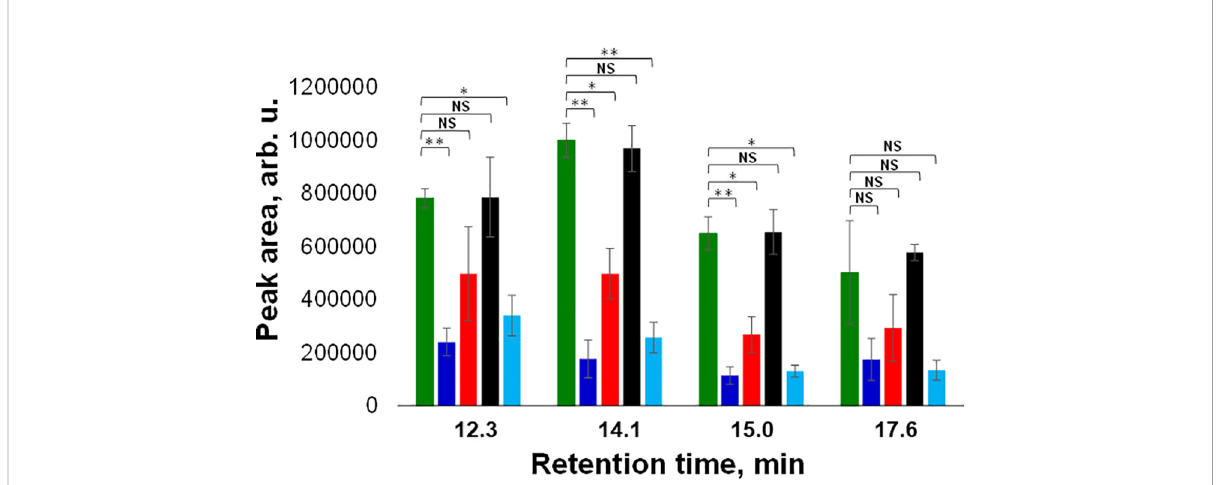
FIGURE 4 Average peak area and corresponding standard deviations of peaks observed in triplicates of HPLC pro fi les of healthy (green), ND- (light blue) and drought (black) stressed plants, as well as wheat exposed to WSMV+TriMV infection (red) and aphid stress (blue). RT=12.3 min = lutein; RT=14.1 min = chlorophyll; RT=15.0 min = pheophytin; RT=17.6 min = b-carotene. NS is a nonsigni fi cant difference, and *P ≤ 0.05, **P ≤